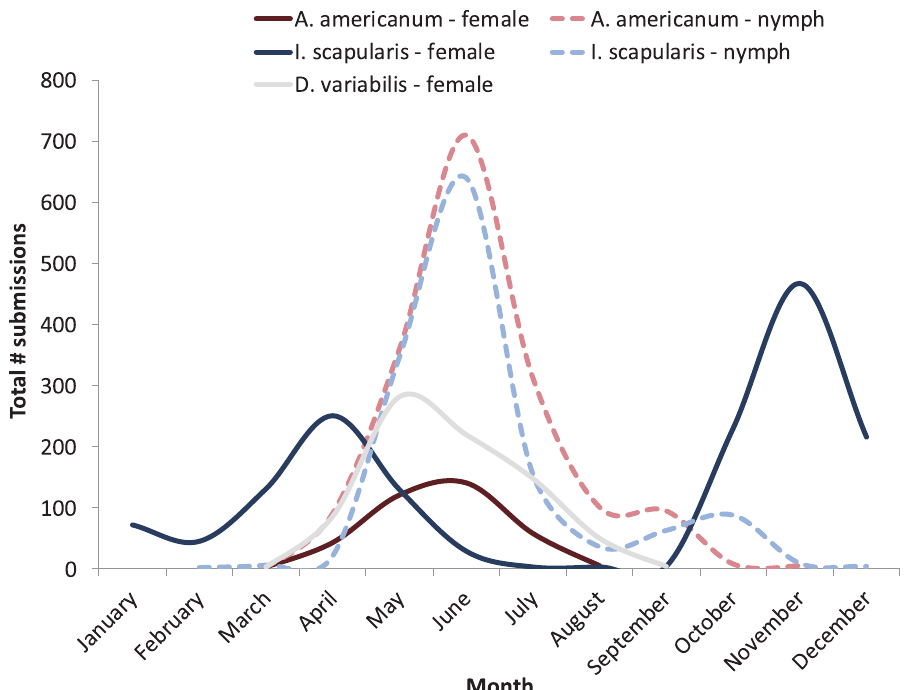
Fig 3. Seasonal phenology of 3 medically-important tick species reflected in passive surveillance submissions. Monmouth County, New Jersey, 2006–2016. Only 2 D . variabilis nymphs were submitted, both during the month of June.